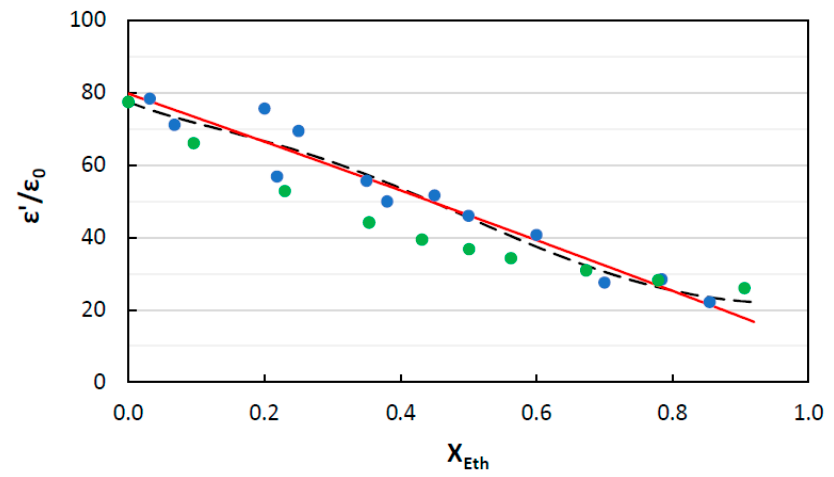
Figure 6. Measured values ( • ), literature values [55] ( • ), Acree model curve (---), and King and Queen model curve ( − ) of ε (cid:48) / ε 0 for the water–ethanol mixtures, reported as a function of the ethanol molar fraction ( x Eth ).